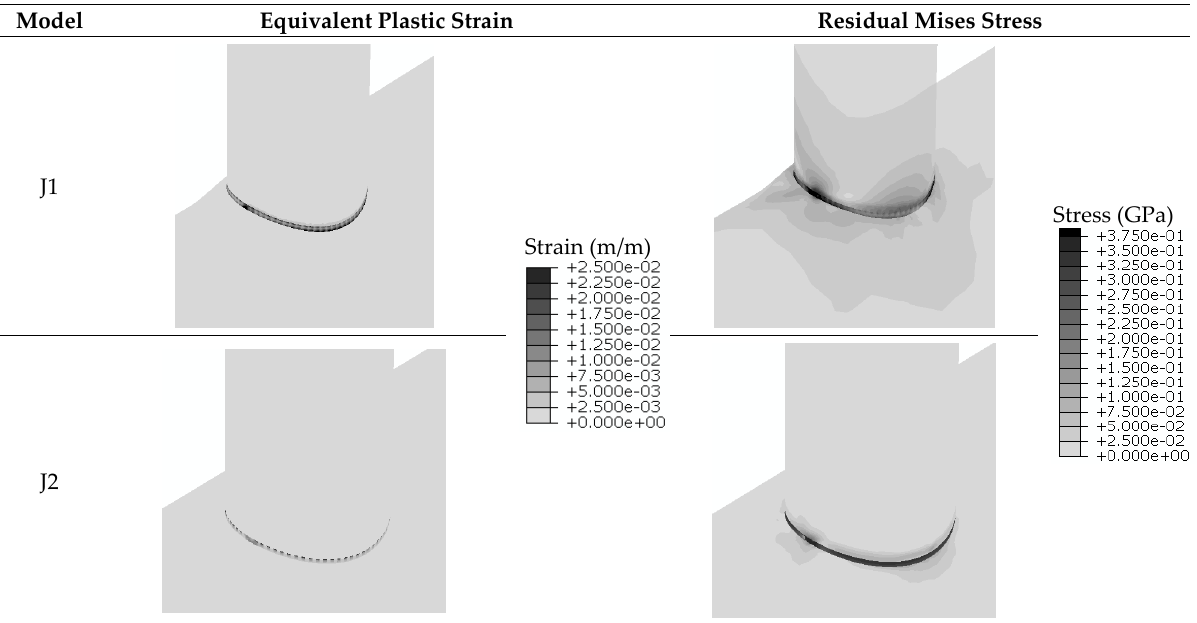
Figure 5. Contours of residual stress and equivalent plastic strain caused by the welding process, J1 and J2 models.